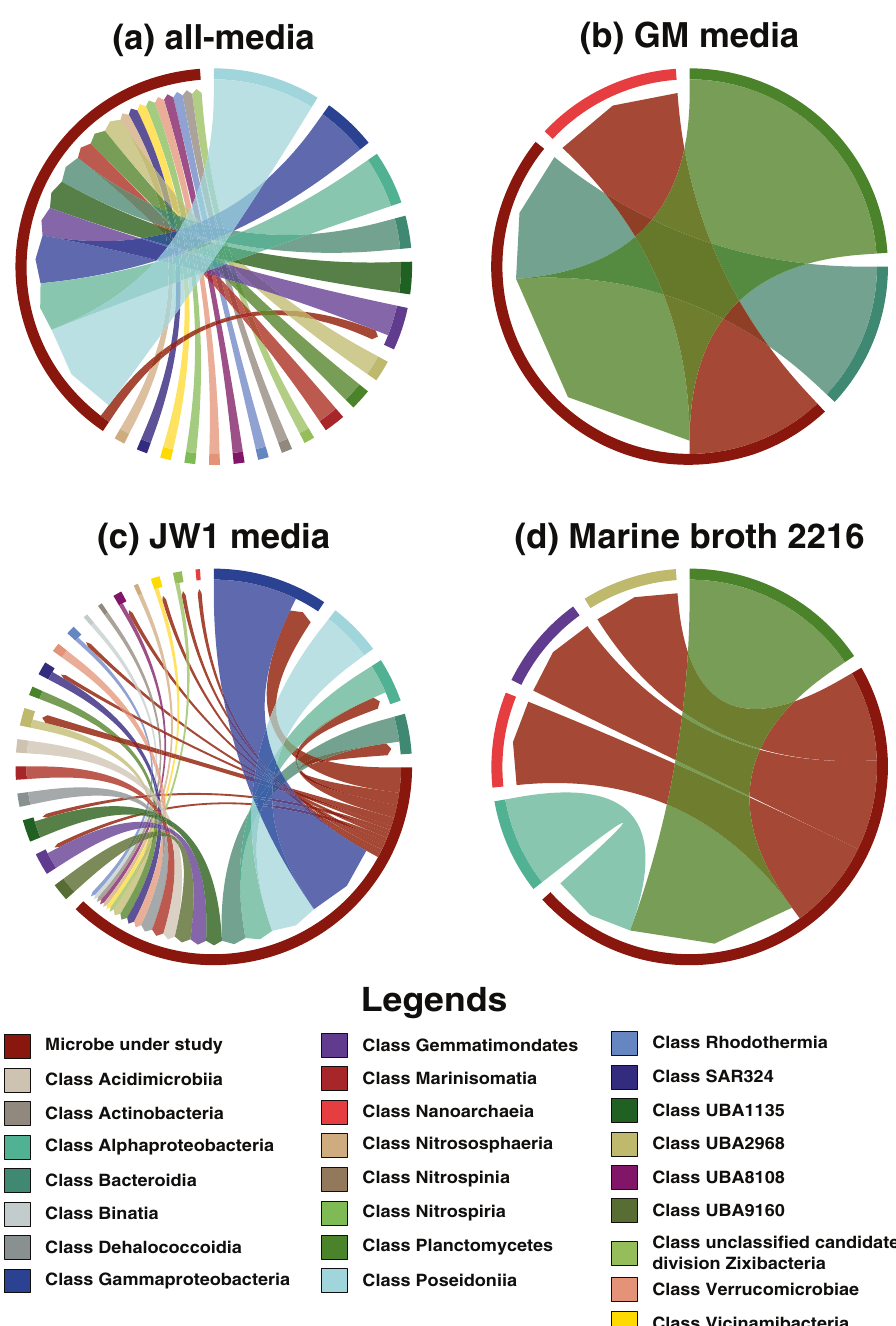
Fig. 3 Pairwise MSI interactions of Nitrosopumilus sp UWMA 0263 with other microbes in the community. This chord diagram shows all possible metabolic interactions between Nitrosopumilus sp. UWMA 0263 and other microbial classes present in the Guaymas microbiome in four different media conditions (a) all-media, (b) GM media, (c) JW1 media, (d) Marine Broth 2216. All the interacting microbes are grouped under their corresponding microbial class except Nitrosopumilus sp. UWMA 0263. The chord starts from the donor microbe/class towards recipient microbe/class. The thickness of the chord represents the number of microbes participating in the interaction from the same class. The colours are mapped to microbial only in all-media and JW1 media (Fig. 4b). The metabolites exchanged in all other microbes are documented in Supple- mentary File S5 and S6.